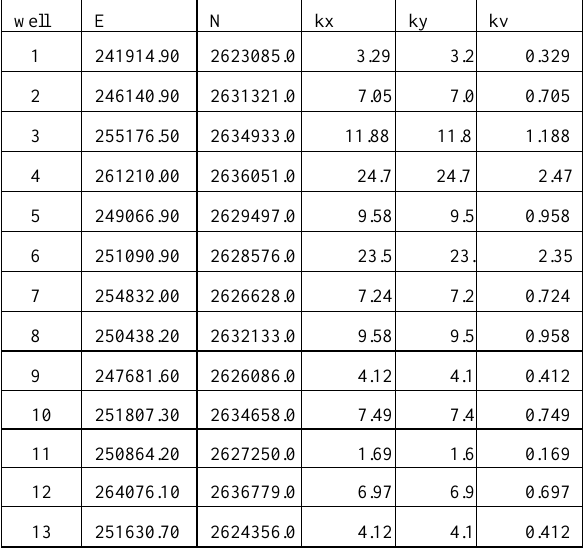
Table 2 Well Location and Conductivity